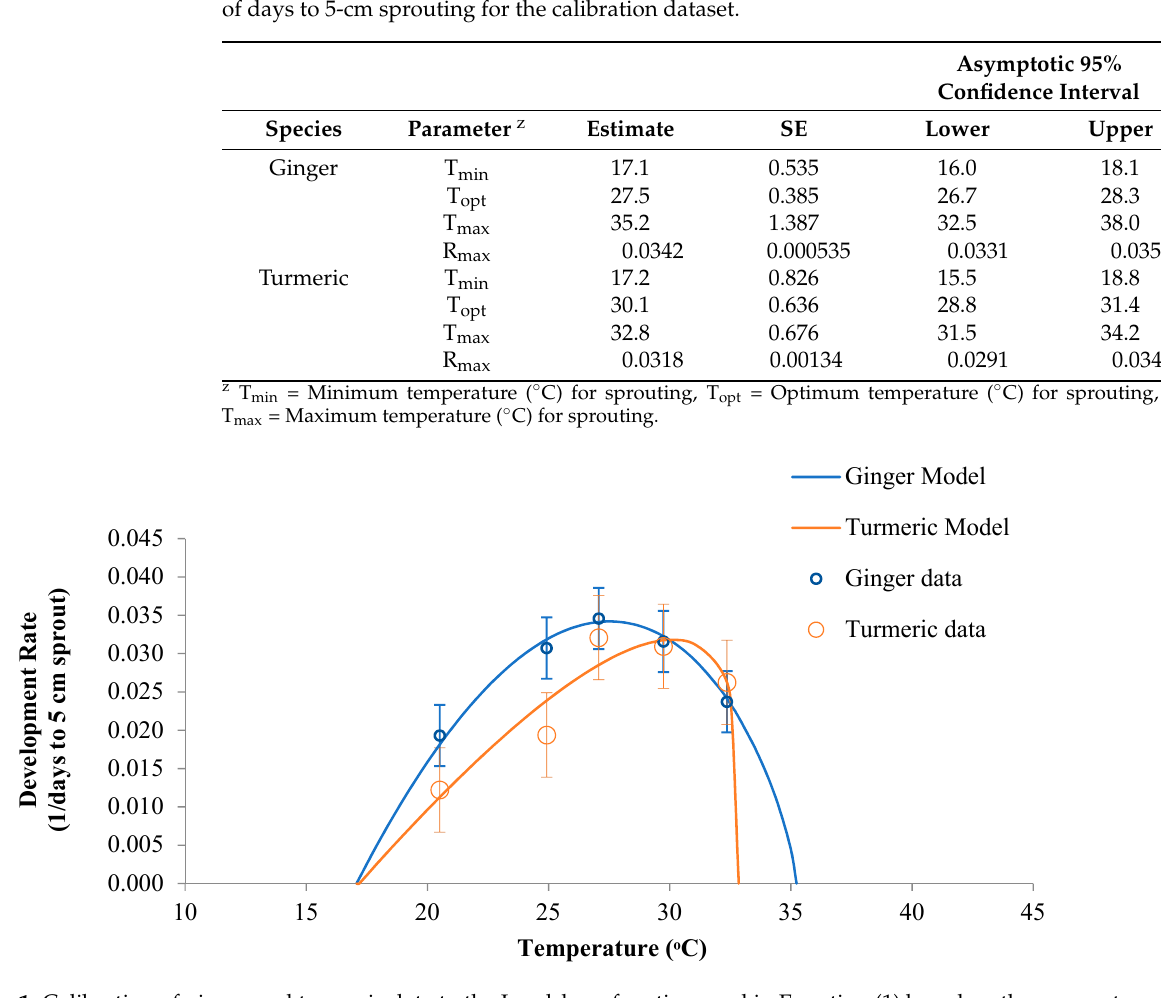
Figure 1. Calibration of ginger and turmeric data to the Landsberg function used in Equation (1) based on the parameters from Table 1. Symbols represent the mean ± 95% confidence intervals. Data were pooled across two cultivars and include 12 rhizomes per species per temperature treatment.